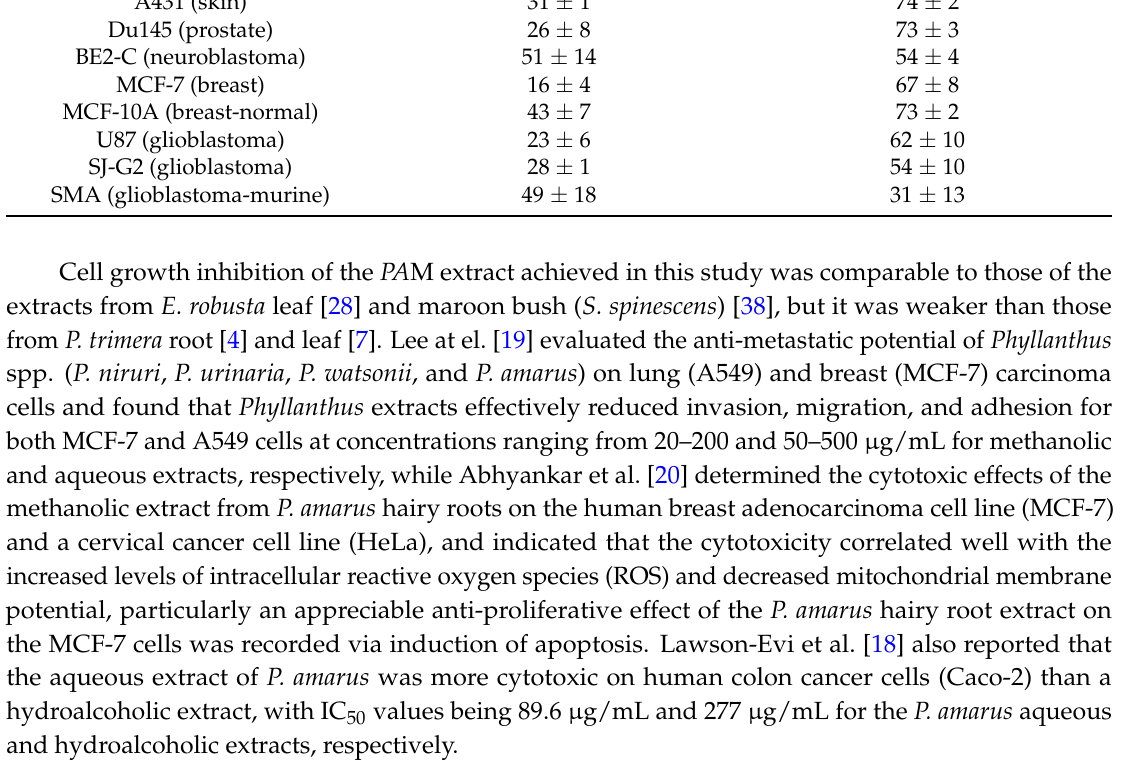
Table 2. Cytotoxic capacity of powdered P. amarus ( PA ) extracts on different cancer cell lines % Cell Growth Inhibition Cancer Cell Line (Cell Type) at 100 µ g/mL of PA Extracts ( n = 3–6) Water ( PA W) Extract Methanol ( PA M) Extract MiaPaCa2 (pancreas) 38 ± 5 48 ± 3 23 ± 3